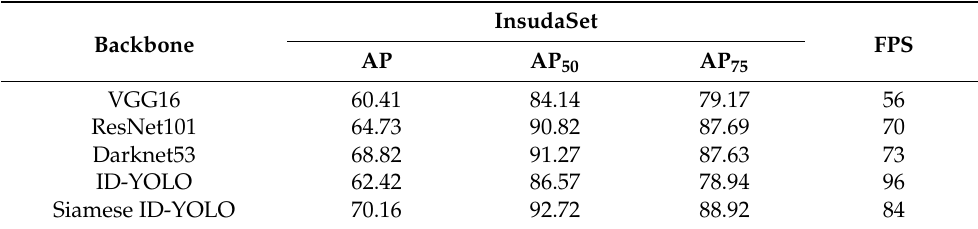
Table 5. Comparison accuracy and speed table of different backbones.